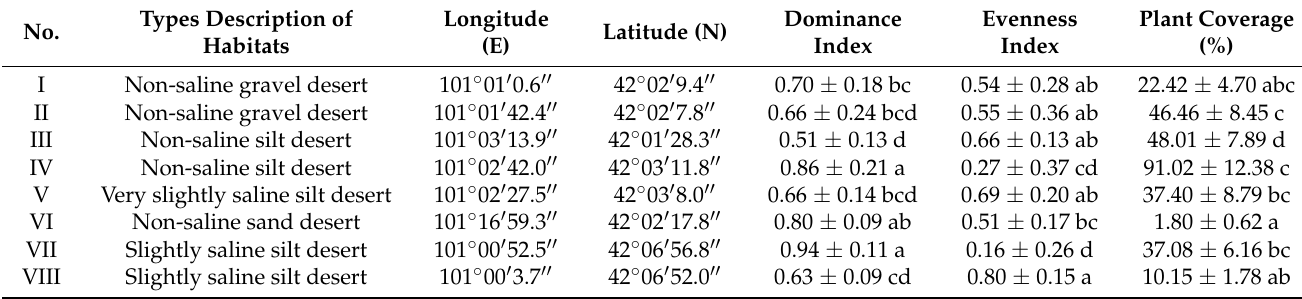
Figure 1. Photos of Lycium ruthenicum community and individual characteristics. Note: A, non-saline desert habitat; B, very slightly saline desert habitat; C, slightly saline desert habitat; D, photo of individual of L. ruthenicum ; E, the underground biomass of L. ruthenicum is mainly distributed in the area of 0–80 cm; F, morphological characteristics of leaves of L. ruthenicum . Table 1. Site characteristics for eight Lycium ruthenicum populations in the lower reaches of Heihe River (Mean ± SD, n = 3).